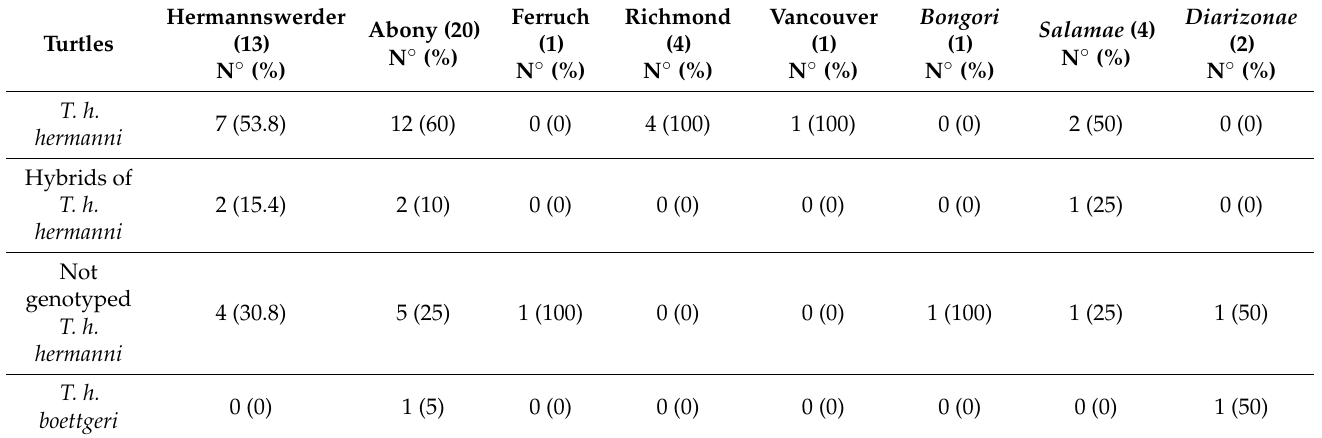
Table 4. Distribution of different types of Salmonella among positive turtles.